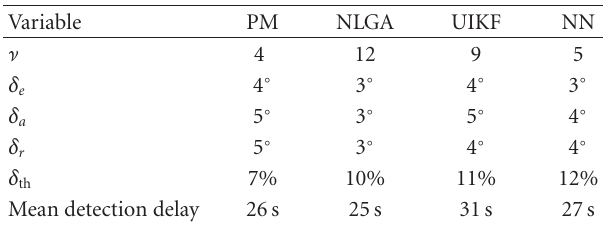
Figure 3: Aircraft complete trajectory example. Table 6: Performances of the FDI schemes for a complete aircraft